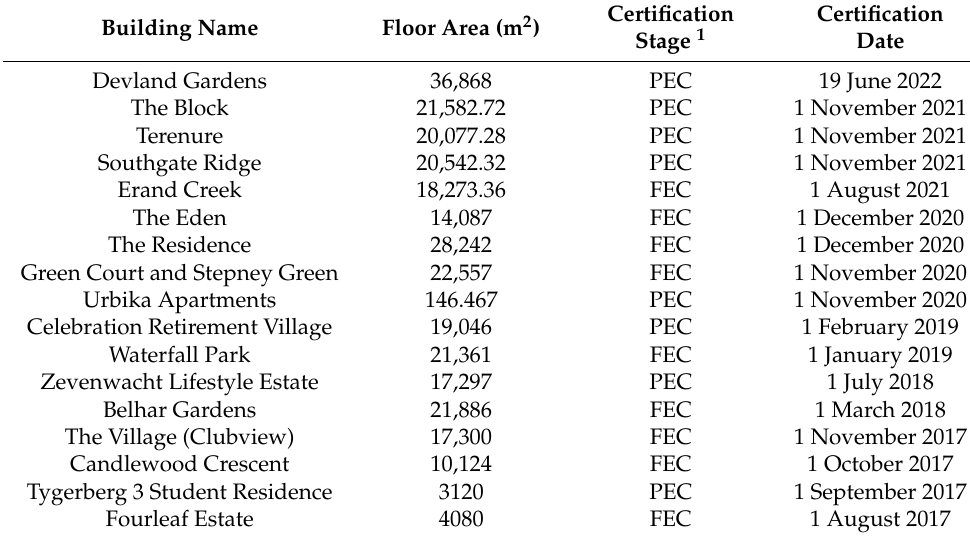
Table 2. Seventeen residential complexes with EDGE certification